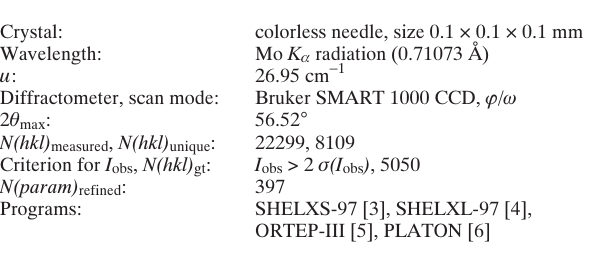
Table 1. Data collection and handling.